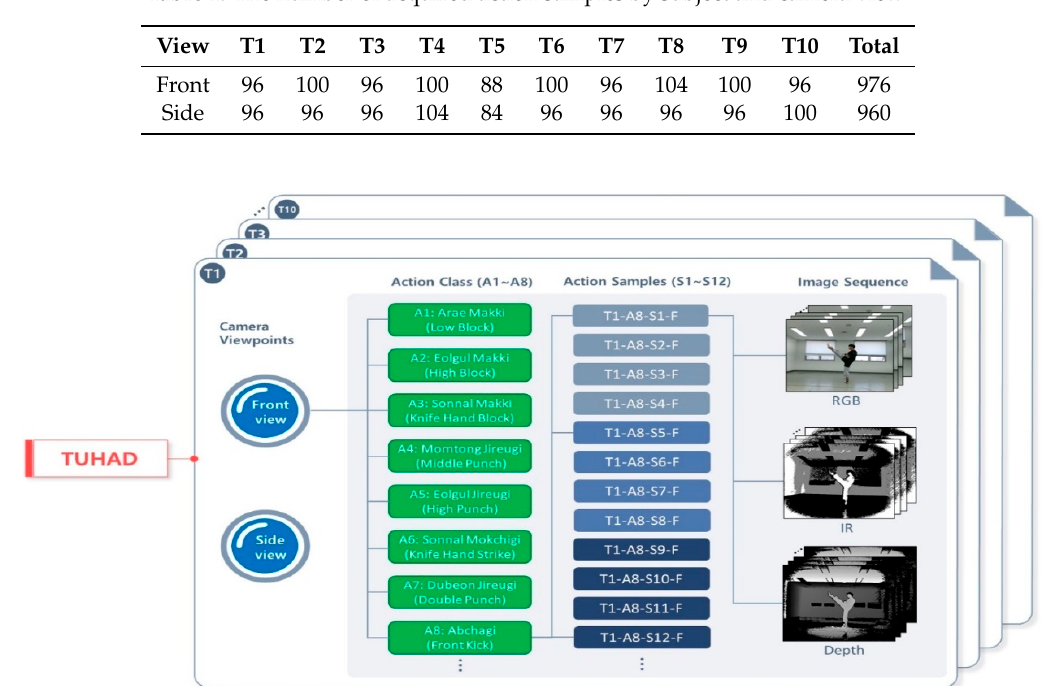
Figure 4. Hierarchy of action classes and action samples in Taekwondo Unit technique Human Action Dataset (TUHAD). Each hierarchy level is repeated at a higher layer.